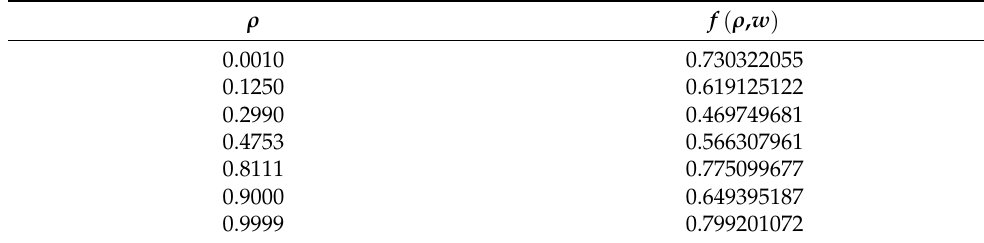
Table 2. Results for the second scenario (rho, solar) in D.S. type two.